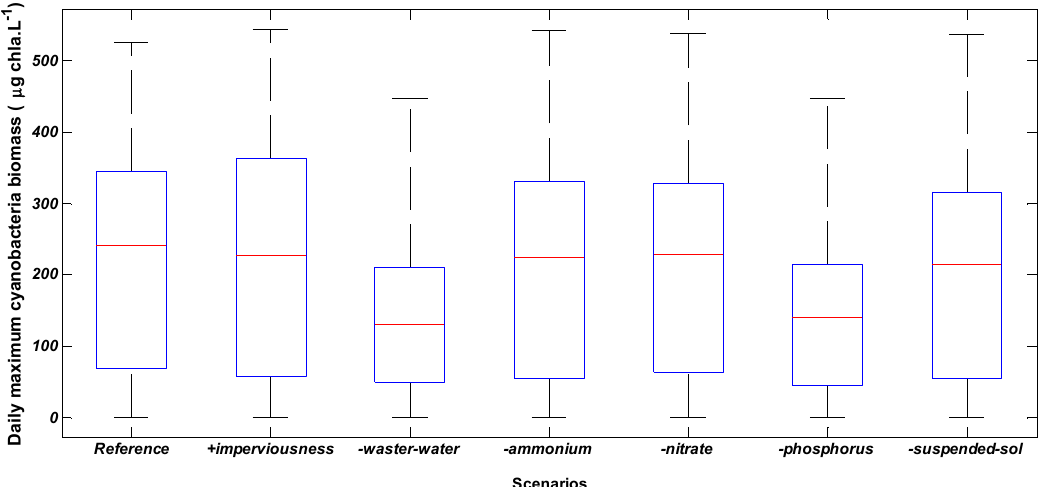
Figure 12. Daily maximum cyanobacteria biomass variation from 1 November 2011 to 31 October 2012